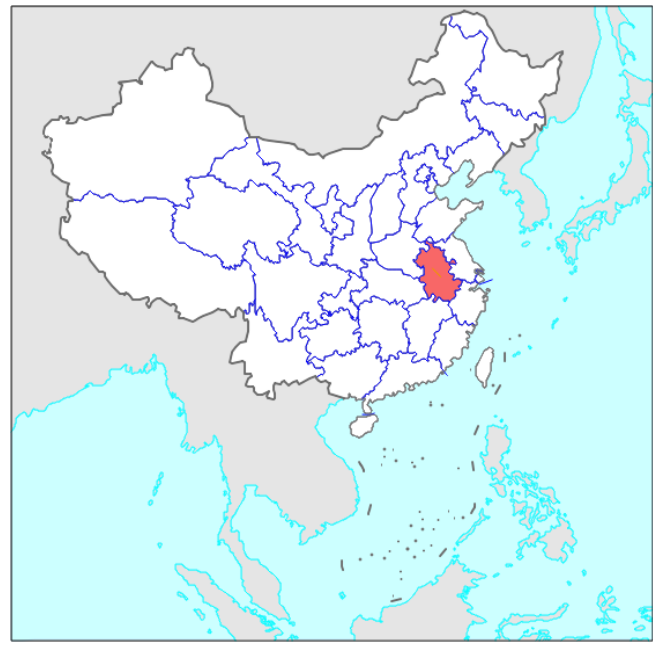
Figure 2. Location of Anhui province in China.